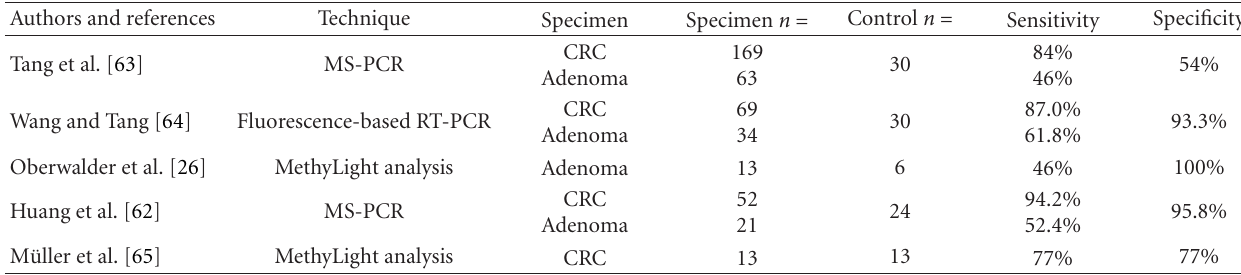
Table 2: Studies of SFRP2 genetic alterations in fecal